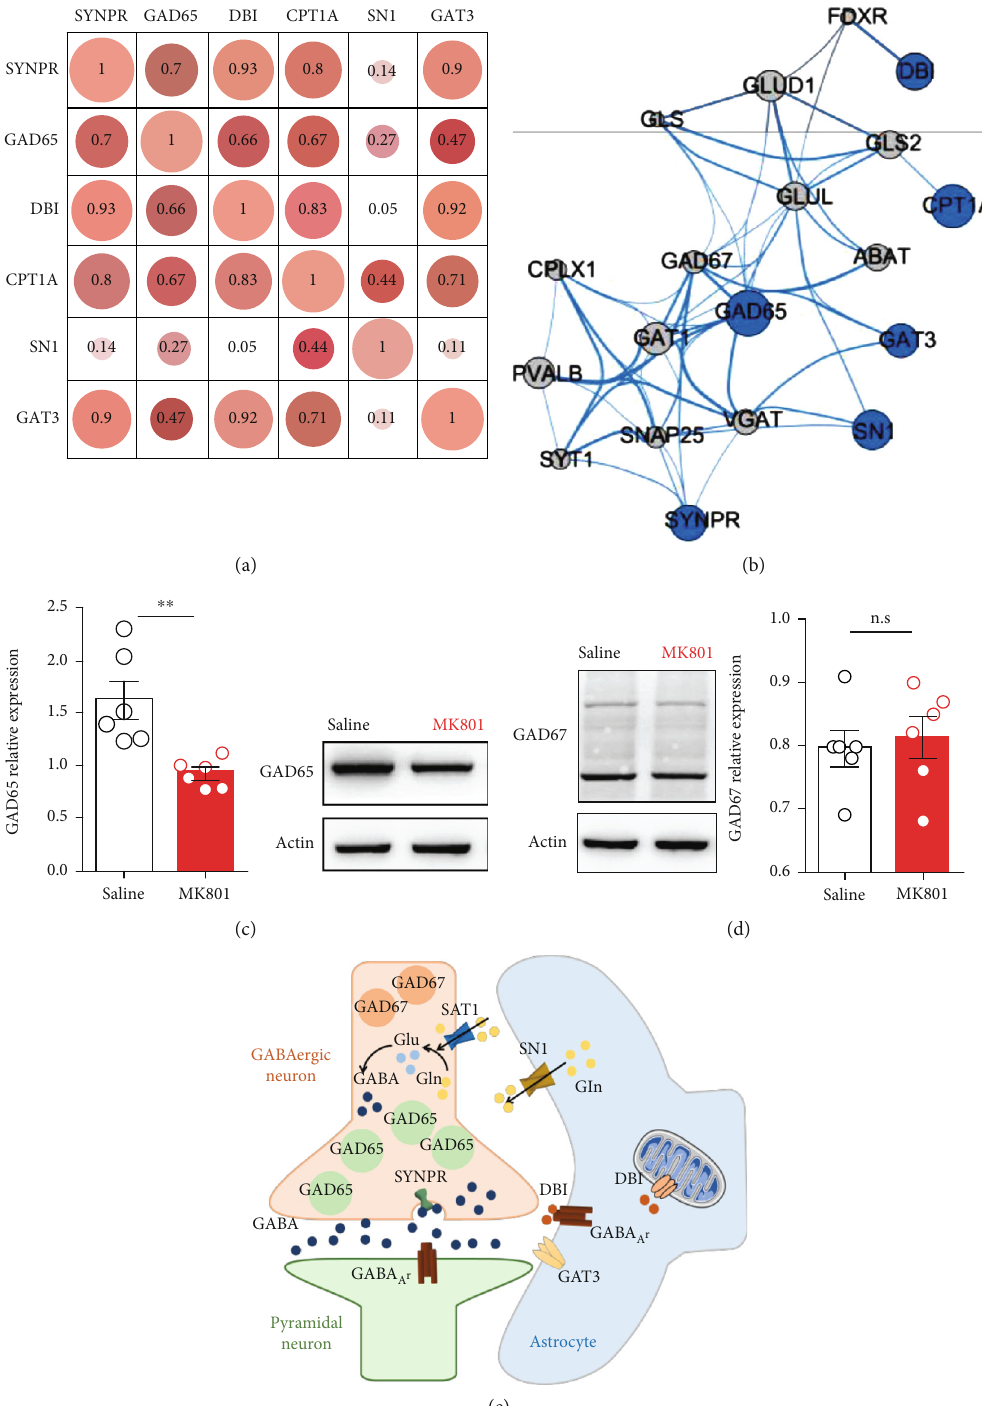
Figure 5: Protein network analysis of GABA neurotransmission. (a) Pearson correlation analysis of the expression of signi fi cant proteins involved in GABA neurotransmission. The number inside the circle represents the R value. (b) Network of proteins involved in GABA neurotransmission. Blue: downregulated proteins. Grey: proteins whose expression were not changed in this study by MS analysis. Circle size represents the value of the adjusted p value. The larger size indicated the smaller p value. The p value of blue circles was below 0.05; otherwise, they were above 0.05. The thickness of lines represents the combined score of edges. (c) Western blot validation of the GAD65 expression, n = 6 of each group, p = 0 : 0043 . (d) Western blot validation of the GAD67 expression. n = 6 of each group, p = 0 : 7108 . Data were represented as mean ± SEM . ∗∗ p < 0 : 01 . Student ’ s t -test. (e) Schema depicting the contribution of downregulated proteins in GABA dysfunction. GAD65 and SYNPR are responsible for GABA synthesis and release, respectively. GAT3 reuptakes GABA in the synaptic cleft. DBI is the GAGB receptor. SN1 transports GABA-derived glutamine to GABAergic neurons for GABA A